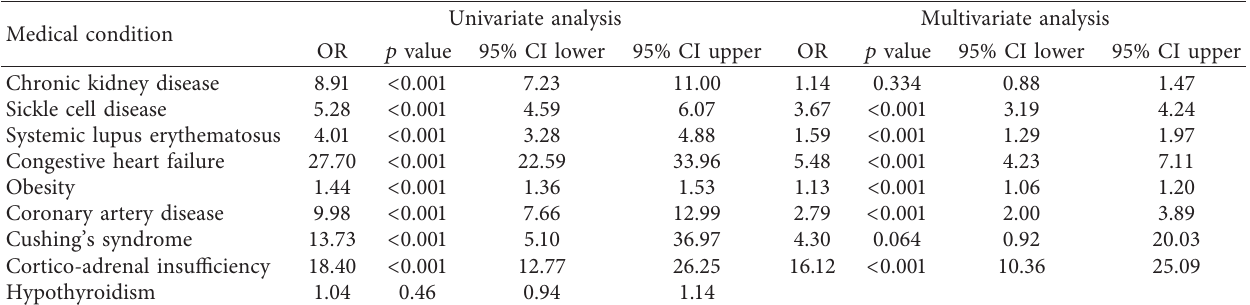
Table 3: Medical conditions and the risk of pregnancy-related